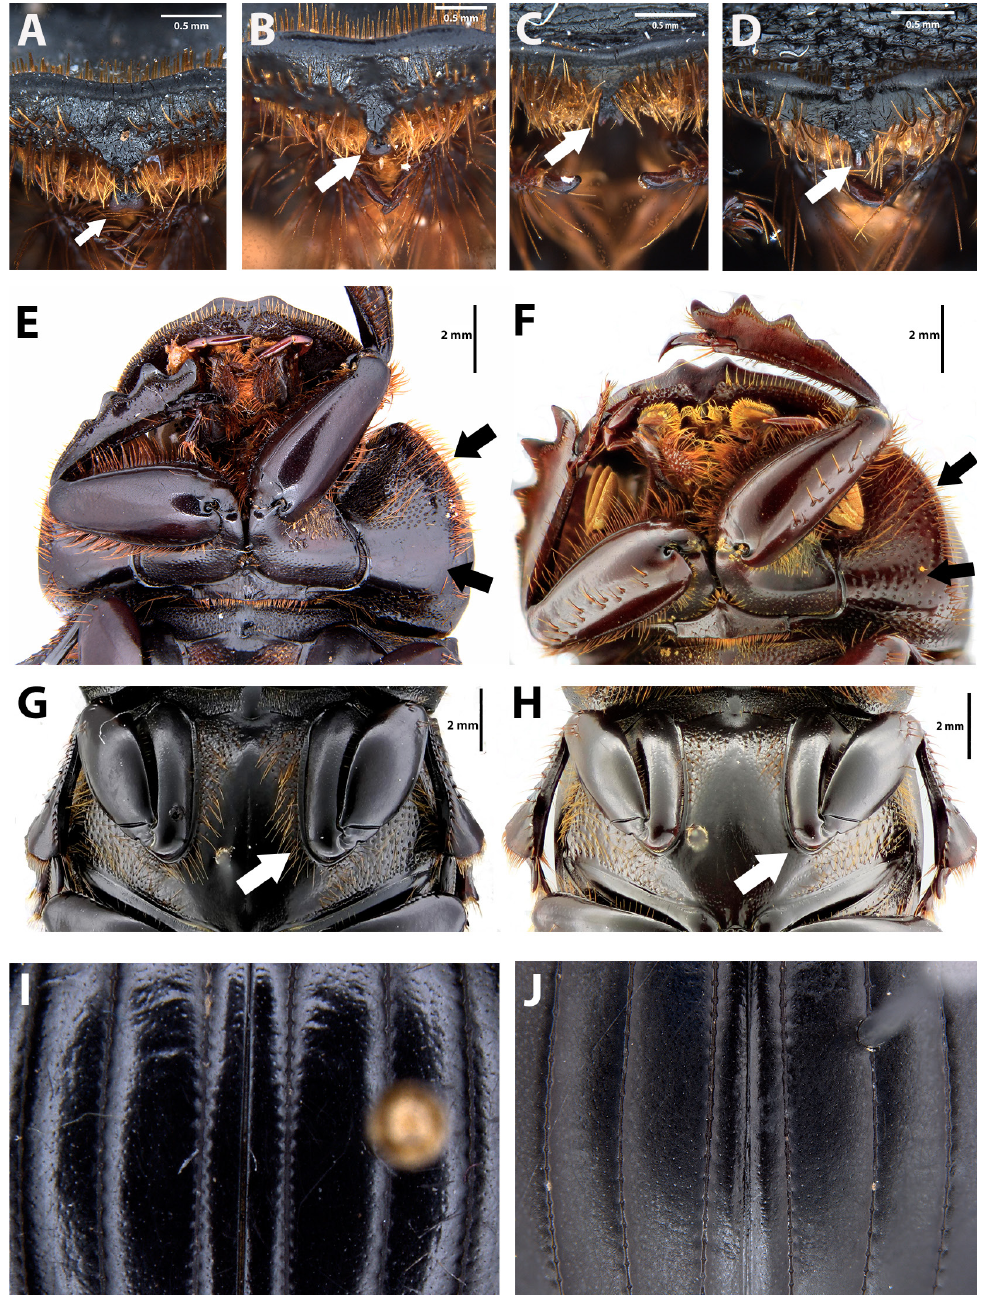
Fig. 2. General characters that help differentiate the species of the Dichotomius ( Luederwaldtinia ) agenor species group. A–D . Ventral clypeal process. A . Cordate as in D. agenor (Harold, 1869). B . Truncate as in D. sagittarius (Harold, 1869) stat. rev. C . Bifurcate as in D. belus (Harold, 1880). D . Cylindrical as in D. henripittieri sp. nov. E–F . Hypomeral characters. E . Medial disc smooth, lateral margin with multiple rows of setae as in D. amplicollis (Harold, 1869). F . Medial disc punctate, lateral margin with single row of setae as in D. tristis (Luederwaldt, 1923). G–H . Metasternum characters. G . Setigerous punctures from the medial and lateral edges joining throughout the margin of the mesocaxa as in D. enioi sp. nov. H . Setigerous punctures from the medial and lateral edges not joining throughout the margin of the mesocaxa as in D. centralis (Harold, 1869) . I–J . Elytra interstriae. I . Smooth as in D. amplicollis . J . Shagreened as in D.